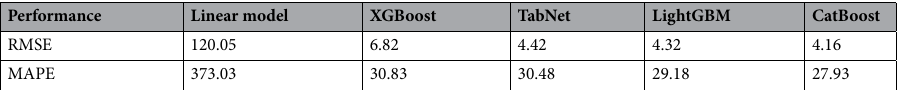
Table 1. Computation time (min) by changing the number of vehicles and requests per day. DTUMOS enables the implementation of extremely large-scale mobility systems at the metropolitan level.